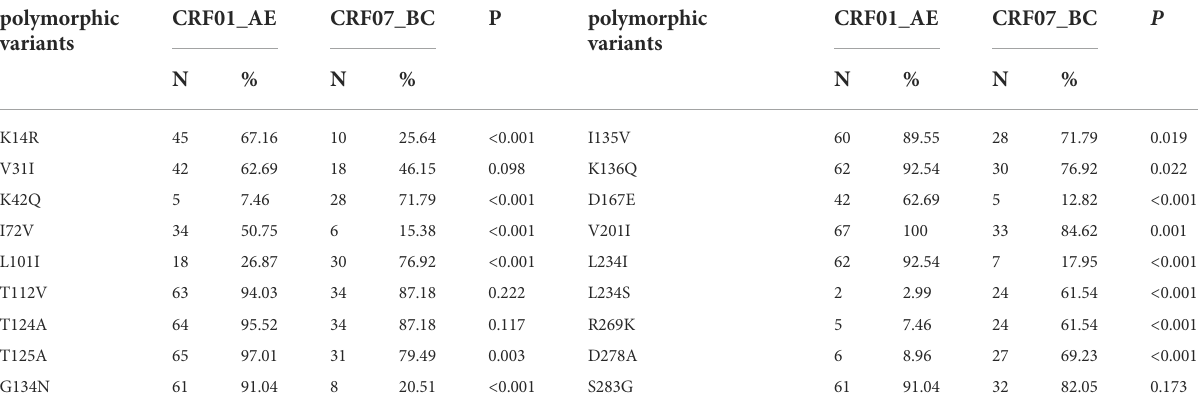
TABLE 3 Natural polymorphisms of CRF01_AE and CRF07_BC strains at integrase resistance-related sites. polymorphic